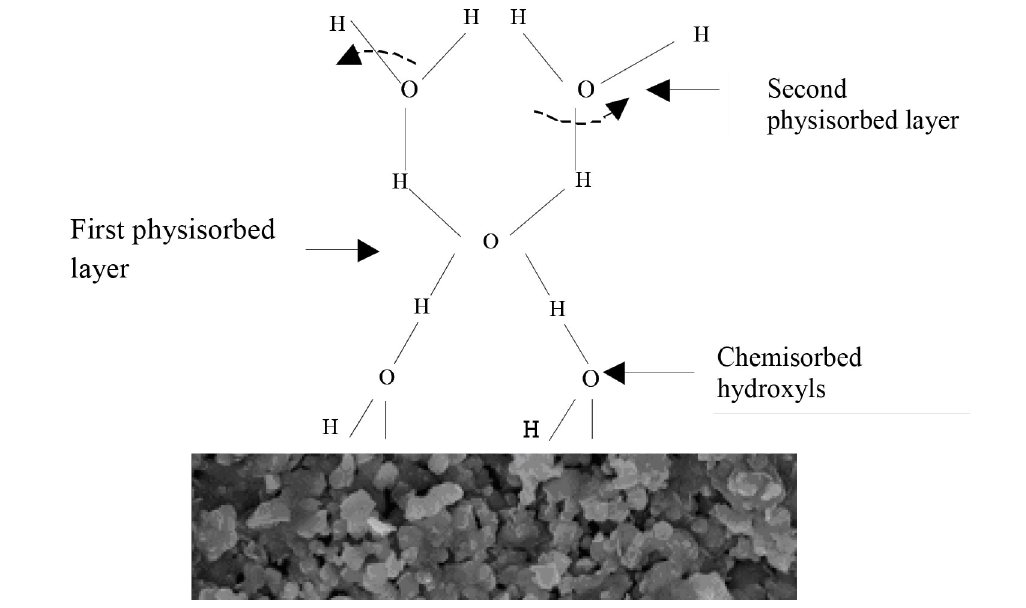
Fig. 7. Schematic of humidity sensing mechanism through a porous